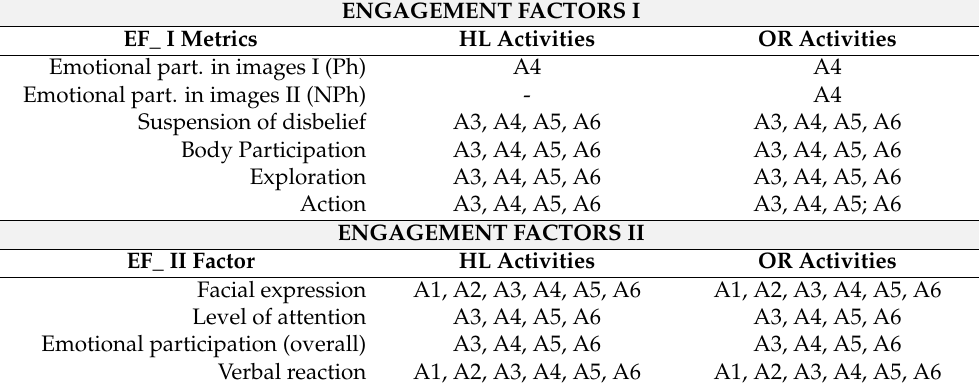
Table 6. Association between metrics and HoloLens (HL)/Oculus Rift (OR) activities.